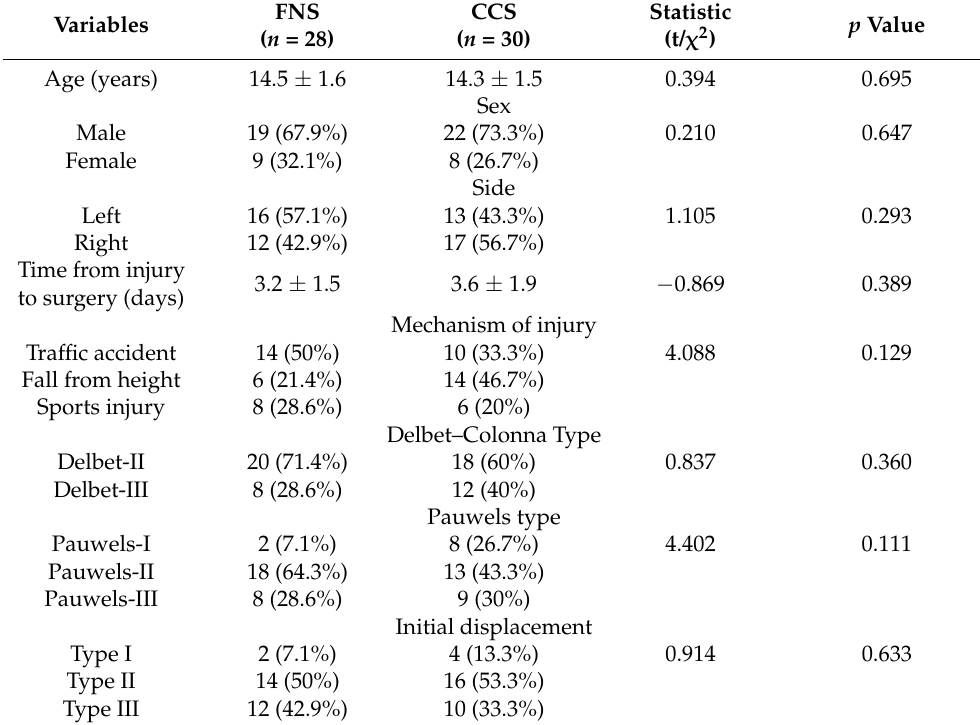
Table 1. Demographic characteristics of the patients.